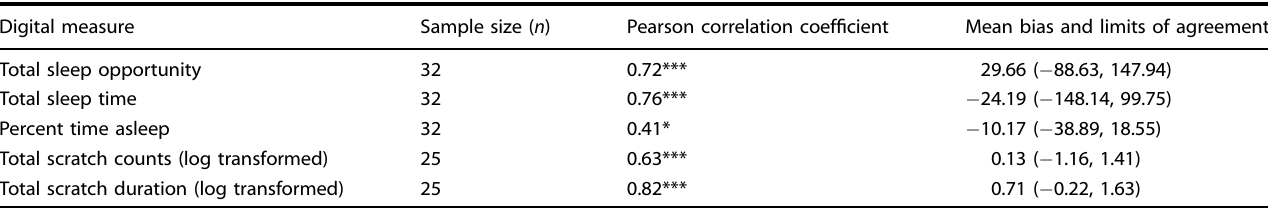
Fig. 1 Binary machine learning scratch classi fi er feature analysis. SHAP 21,22 analysis was used to assess feature importance and impact on classi fi er predictions. SVM signal vector magnitude, PC1 fi rst principal component of signal, PC2 second principal compo- nent of signal. Features of signal periodicity (e.g. dominant frequency, mean cross rate) and smoothness (e.g. sparc, jerk) are predominant features for distinguishing scratch movements from other restless movements. Further, high values of mean cross rate and dominant frequency increase the likelihood of scratch being predicted, indicating scratching movements involve more rapid and periodic hand movements compared to restless movement. Similarly, high values of jerk and low values of sparc are predictive of scratch, indicating that scratch movements are more irregular and less smooth compared to restless movements. Table 3. Agreement of predicted digital summary endpoints with reference system (PSG for sleep, video annotations for scratch) derived